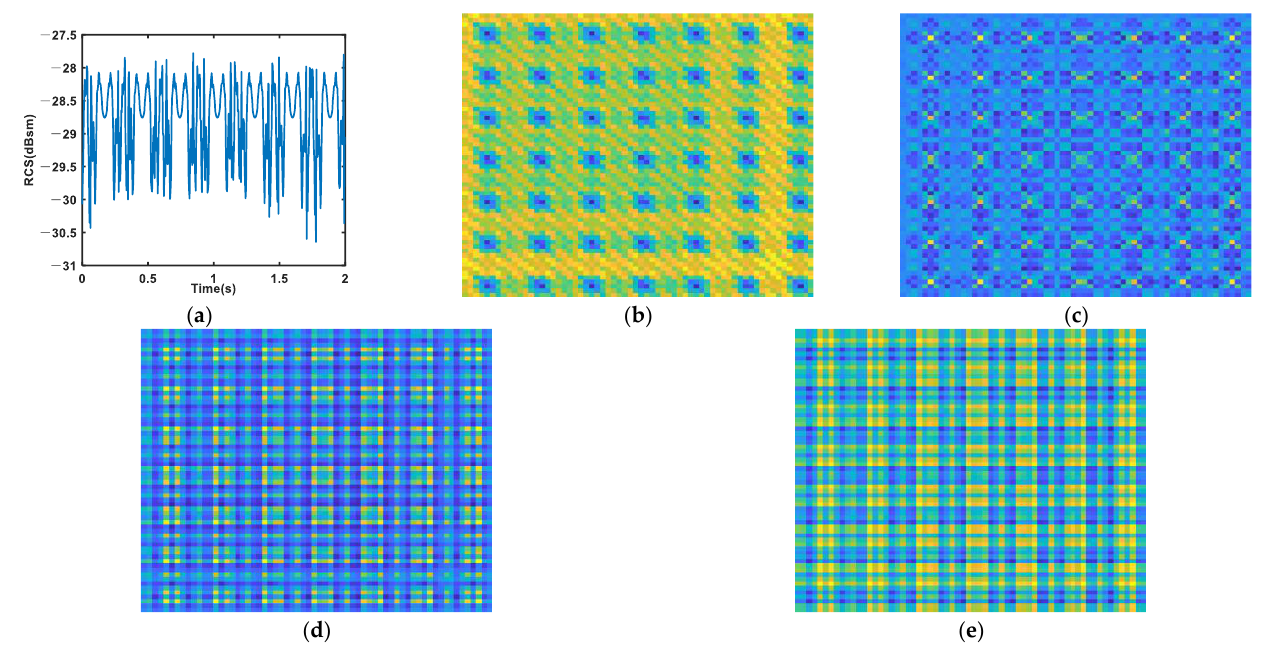
Figure 4. ( a ) RCS; ( b ) RP; ( c ) MTF; ( d ) GASF; ( e ) GADF . RCS sequences encoding of the warhead.